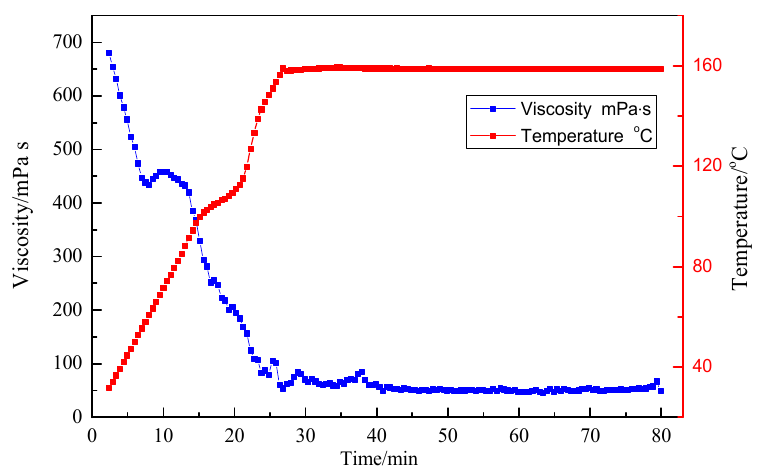
Figure 5. Shear resistance of 5 wt % VES-T with 1.4 wt % KCl fracturing fluid at 160 °C, 170 s − 1 . Polymers 2018 , 10 , x FOR PEER REVIEW